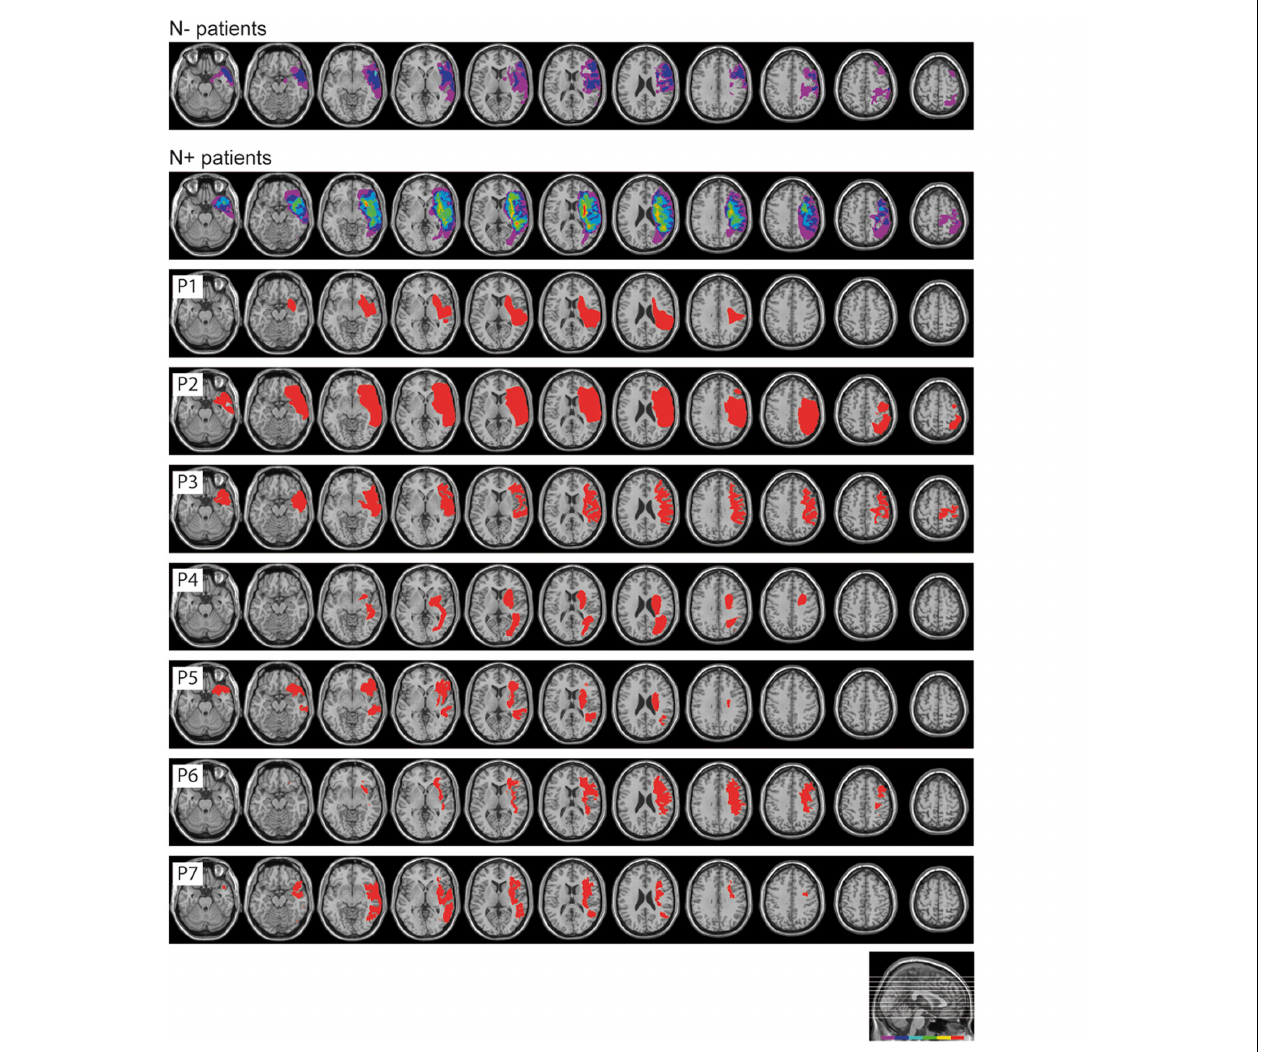
FIGURE 1 | Lesion site of patients with and without USN. Superimposed overlapping brain lesions (first two rows), and lesional mapping for each USN patient (P1–P7).The lesions were mapped using MRIcro software